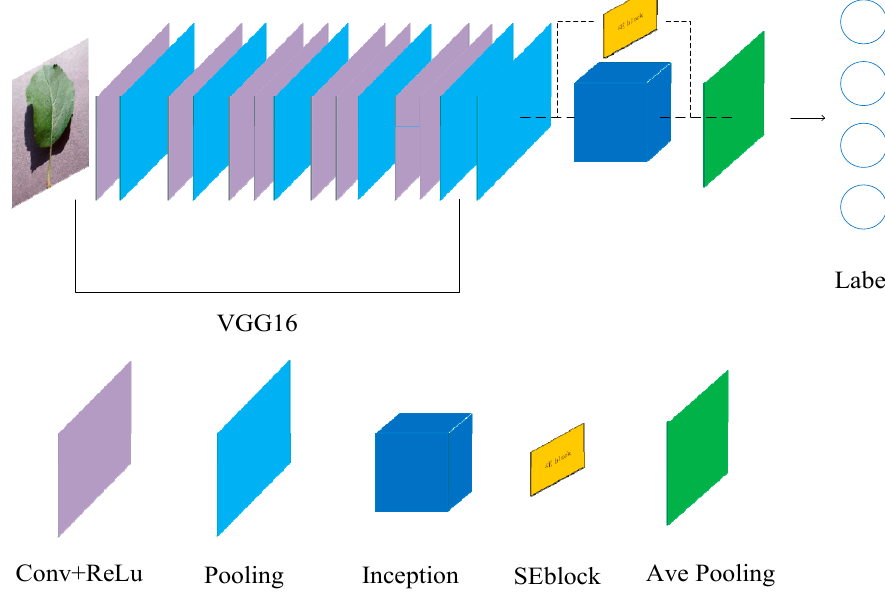
Figure 2. The structure of the proposed convolutional neural network (CNN).